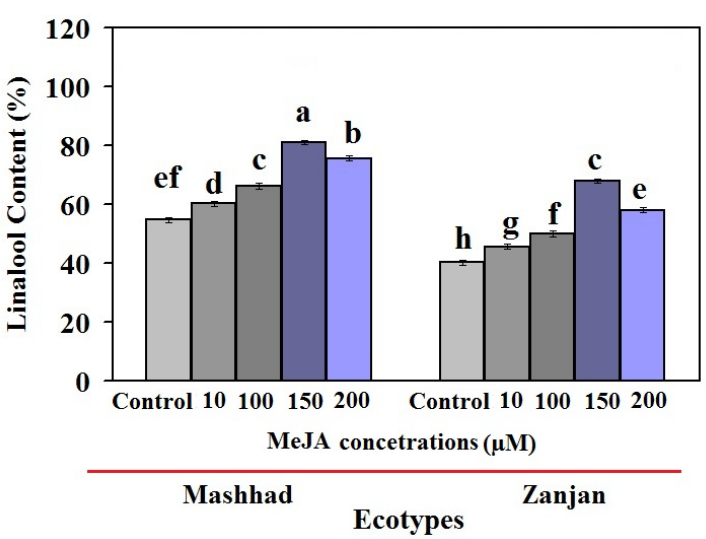
Figure 2. Linalool content of Iranian coriander ecotype leaves after various MeJA treatments. According to Duncan’s test, bars with different lettering indicate significance at a 1% level of probability. Error bar are shown in percent of standard deviation.